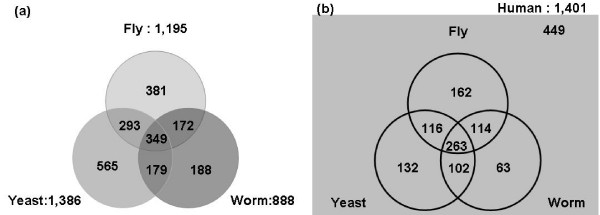
A Venn diagram for the numbers of domains in yeast, worm, fruitfly, and humans. (a) The numbers of domains in yeast, worm, and fruitfly. (b) The numbers of domains between humans and the other three species.